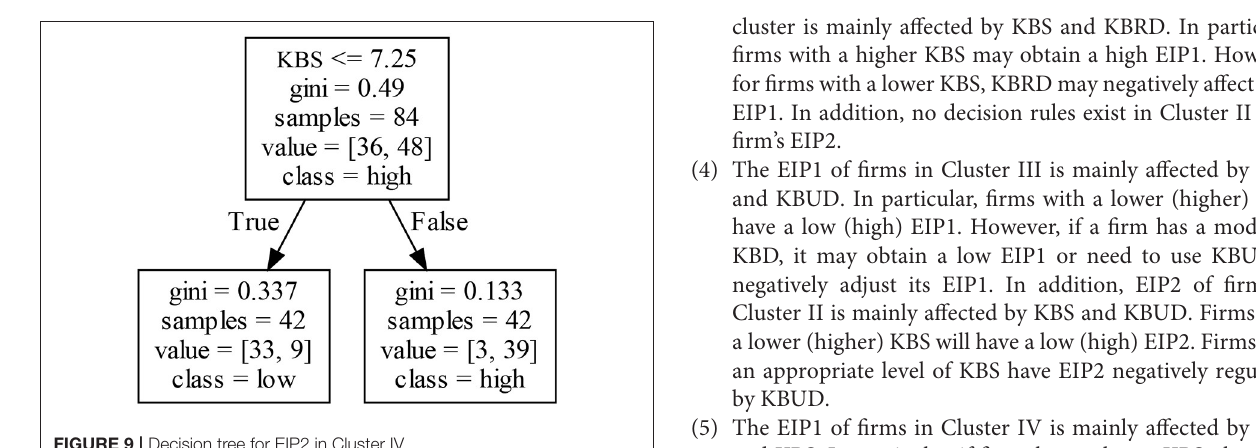
a high (low) EIP2. This result may be because firms with different accumulations of existing knowledge may